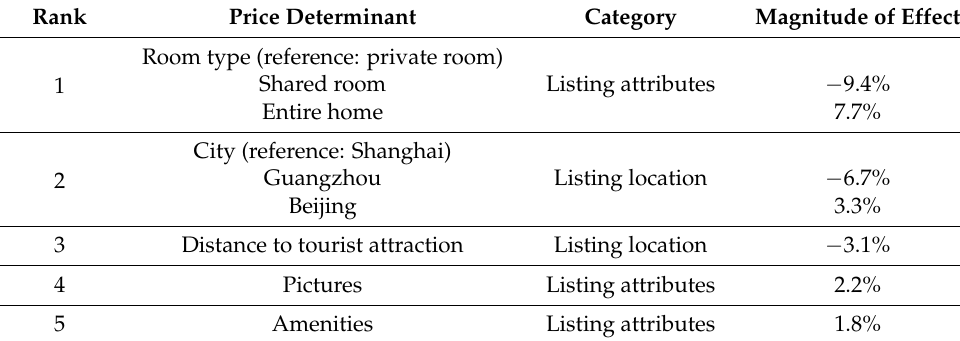
Table 5. Top five price determinants of accommodation